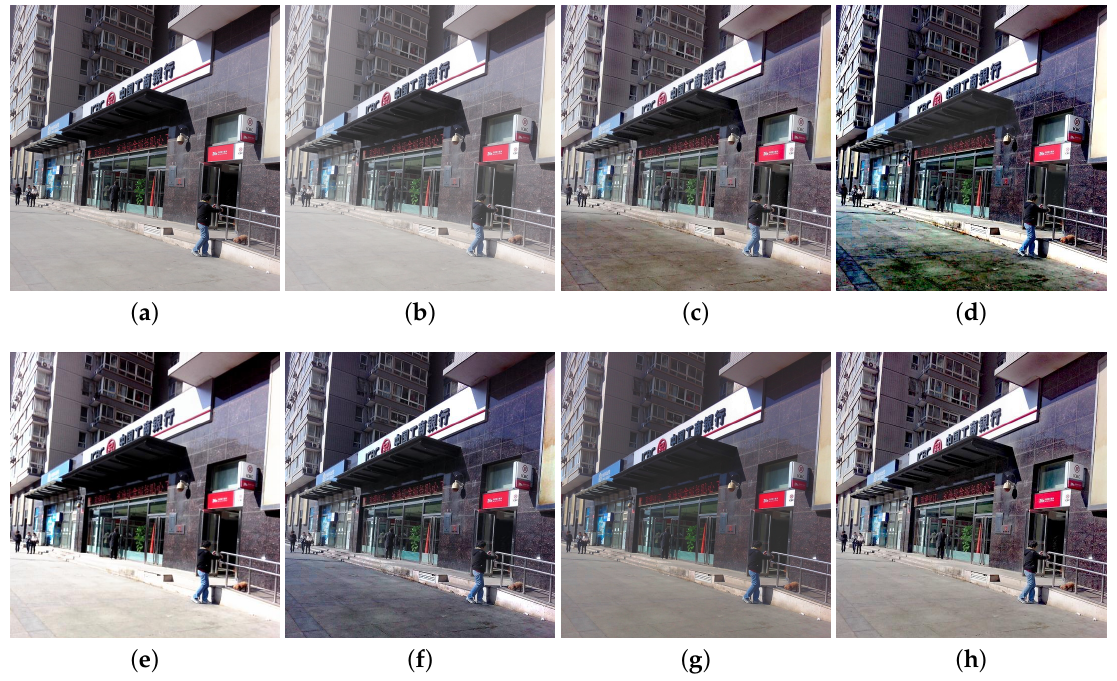
Figure 9. Bank of the SOTS-outdoor dataset.( a ) Ground truth image. ( b ) input blur image. ( c ) DCP;